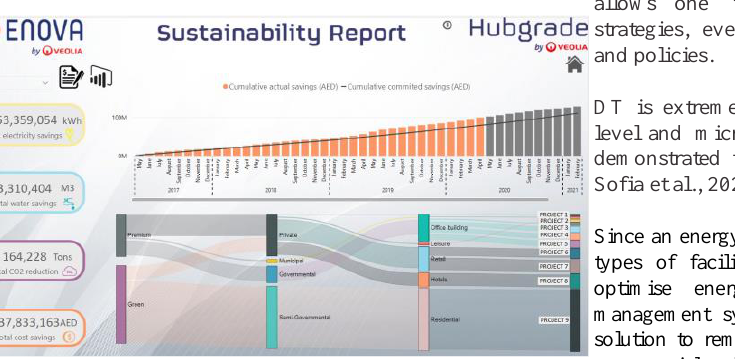
Figure 7: Comprehensive Macro Dashboard for different types of buildings, including residential, commercial, and industrial